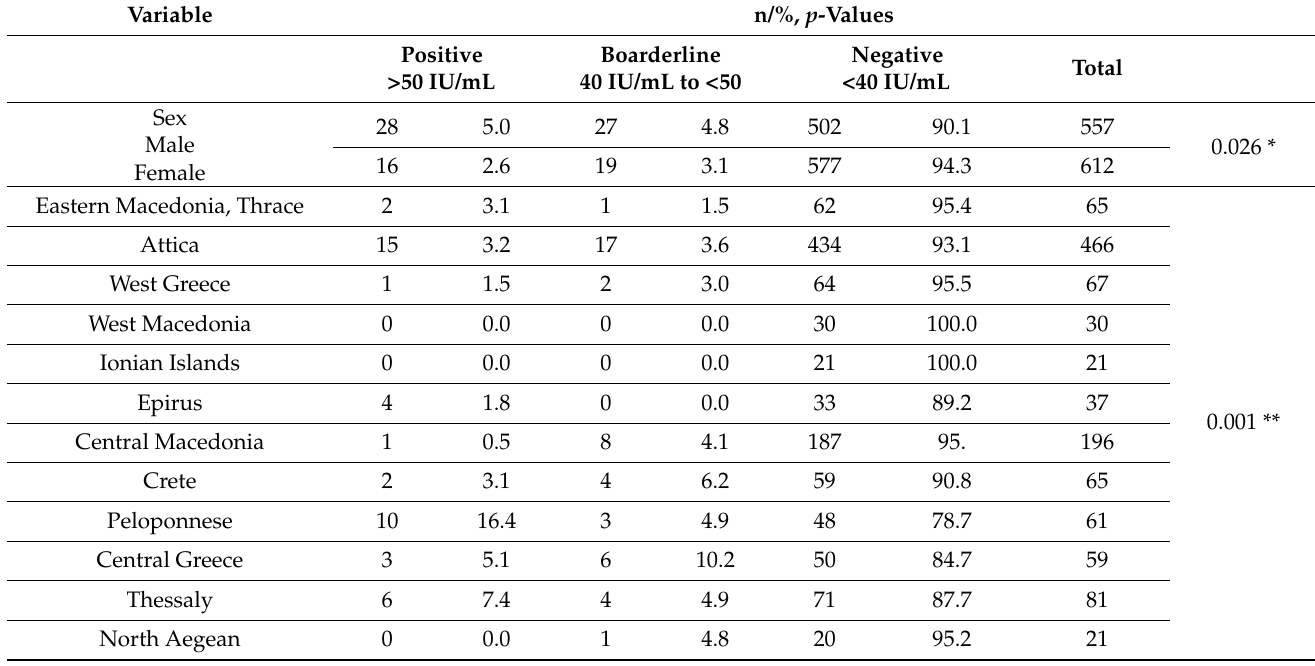
Table 2. Pertussis IgG prevalence by sex and region.